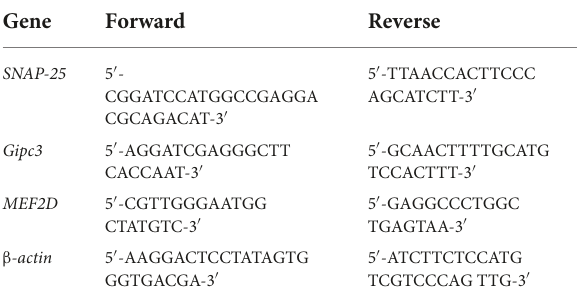
TABLE 1 Primers for quantitative real-time